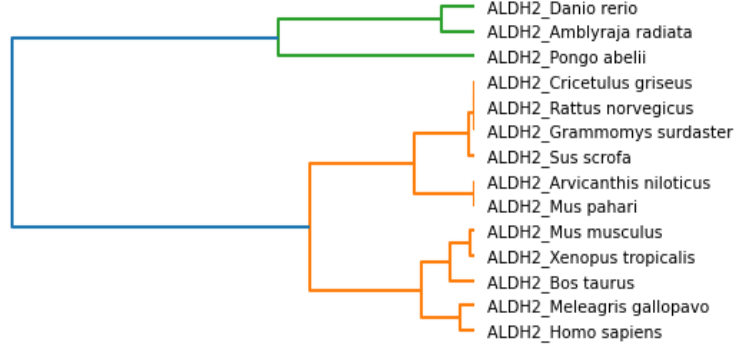
Figure 17. Hierarchical clustering phylogenetic tree based on Shannon